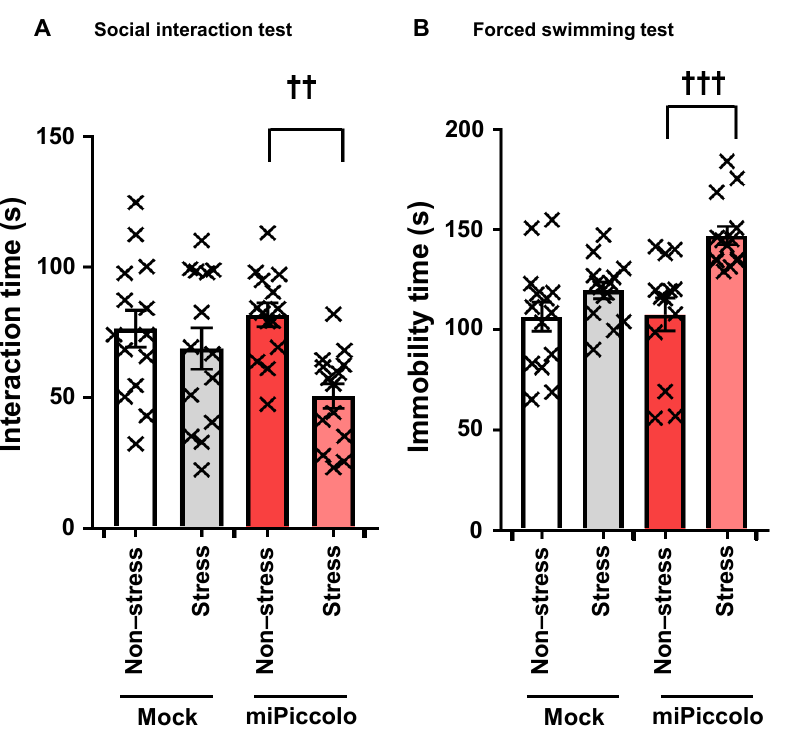
Figure 5. Stress sensitivity in miPiccolo mice. ( A ) After exposure to mild social defeat stress, the time in the interaction zone was measured for 10 min (n = 14). †† p < 0.01 vs. miPiccolo/non-stress (one-way ANOVA followed by Tukey’s post-hoc test). ( B ) After exposure to mild social defeat stress, the immobility time in water was measured for the final 5 min during a 6-min time frame (n = 13–14). ††† p < 0.001 vs. miPiccolo/non-stress (one-way ANOVA followed by Tukey’s post-hoc